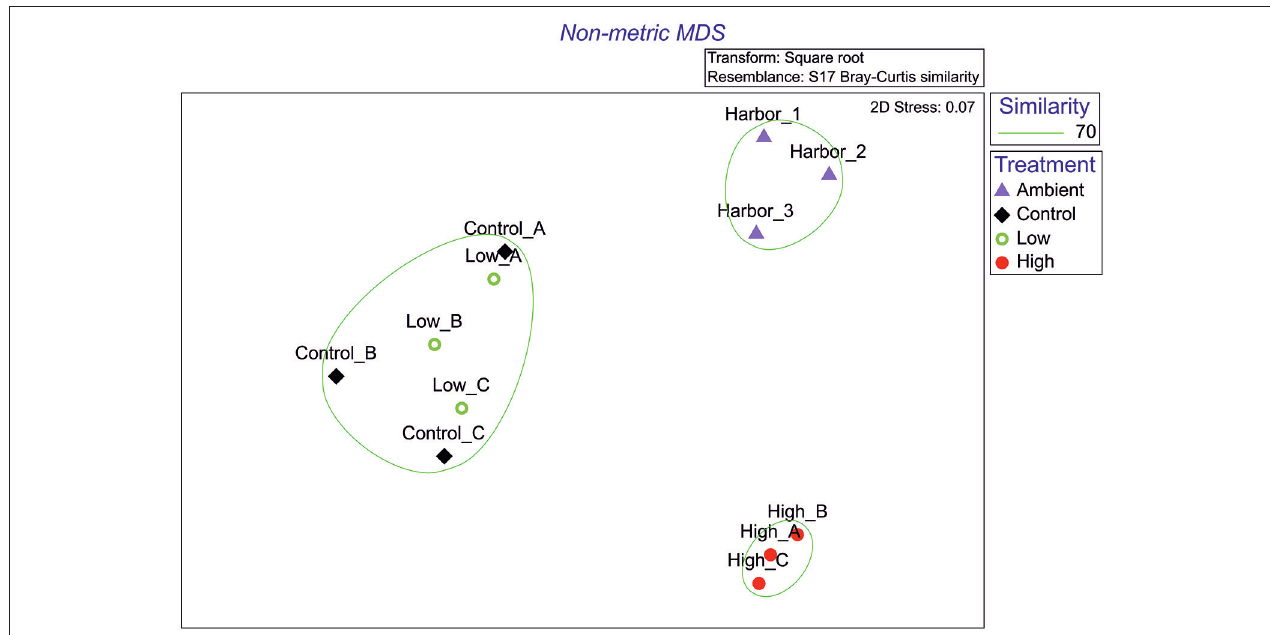
FIGURE 1 | Non-metric Multidimensional Scaling plot from macrofaunal data (Purple triangle, Ambient conditions; Black rhombus, Control; Green circle, Low eutrophication; Red filled circle, High eutrophication).